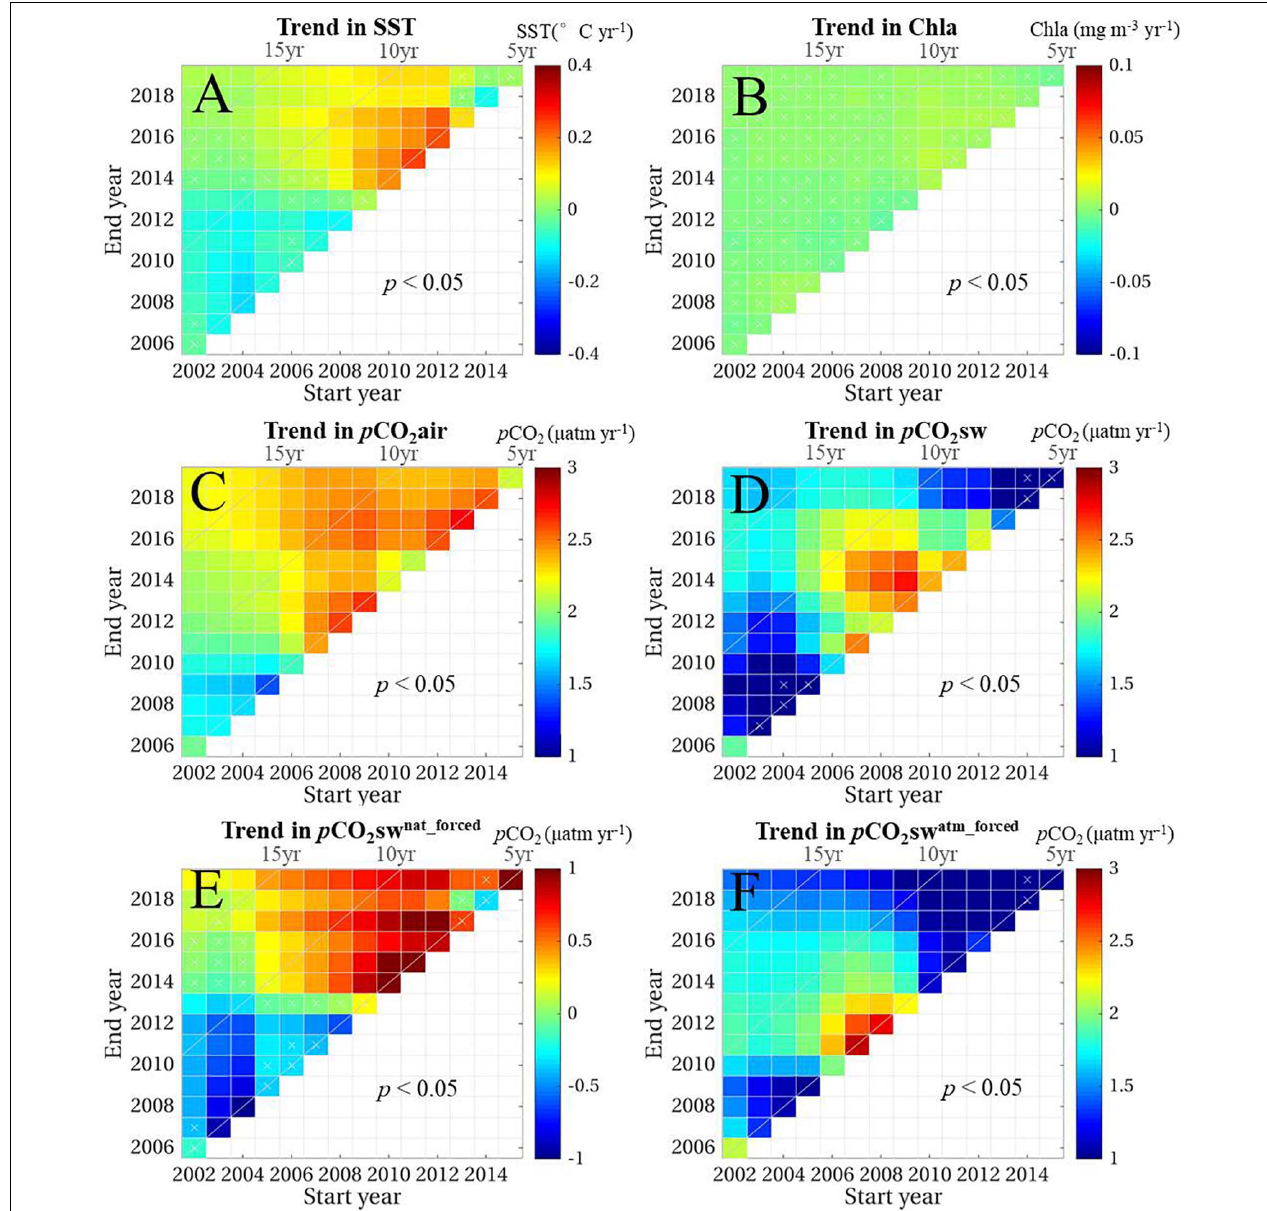
FIGURE 8 | Interannual changing rates of SST (A) , Chla (B) , p CO 2 air (C) , modeled p CO 2 sw (D) , modeled p CO 2 sw nat_forced (E) , and p CO 2 sw atm_forced (F) for a variety of periods starting between 2002 and 2015, and ending between 2006 and 2019 at Station WHOTS. The X-axis and Y-axis represent the start year and end year, respectively, of each rate analyzed. The diagonal lines (i.e., 5, 10, and 15 years) indicate the length of trend periods. A white cross is superposed on the plot when the p value was >